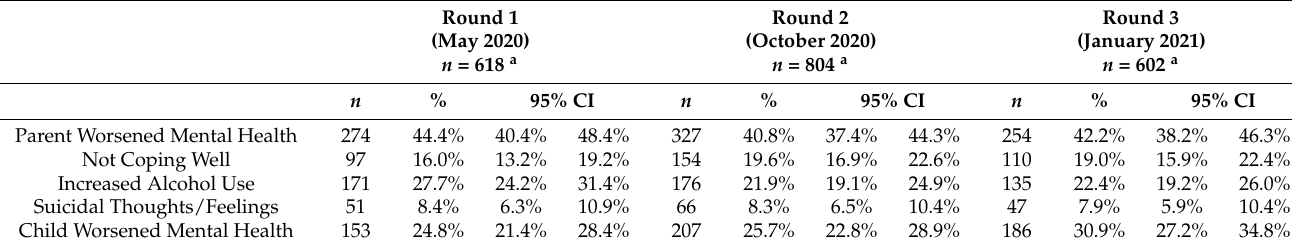
Table 2. Proportion of parents reporting mental health outcomes, by survey round.